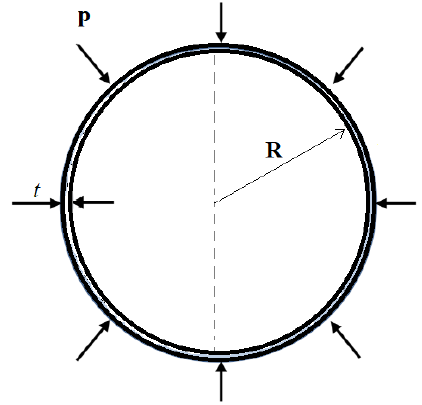
Figure 7. Perfect sphere subjected to external pressure underwater.